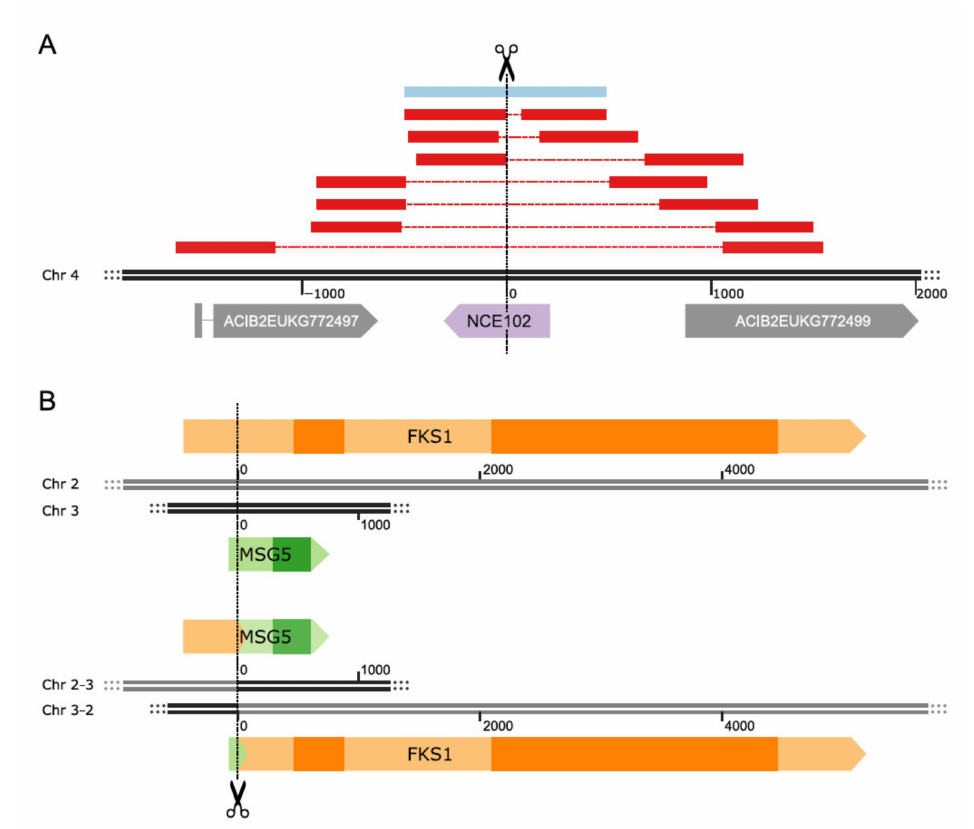
Figure 3. Detailed views of exemplary variants observed after CRISPR/Cas9-based strain engineering. ( A ) Overview of all deletion events at the NCE102 locus, the red and blue bars indicate 1000 bp sequences upstream and downstream of the breakpoint aligned to the wildtype sequence. The blue bar corresponds to the detected in-frame deletion. The dashed lines represent the deleted regions. ( B ) The rearrangement of the MSG5 and FKS1 genes, with the wildtype genes at the top and the rearranged genes at the bottom. Darker regions within genes correspond to conserved